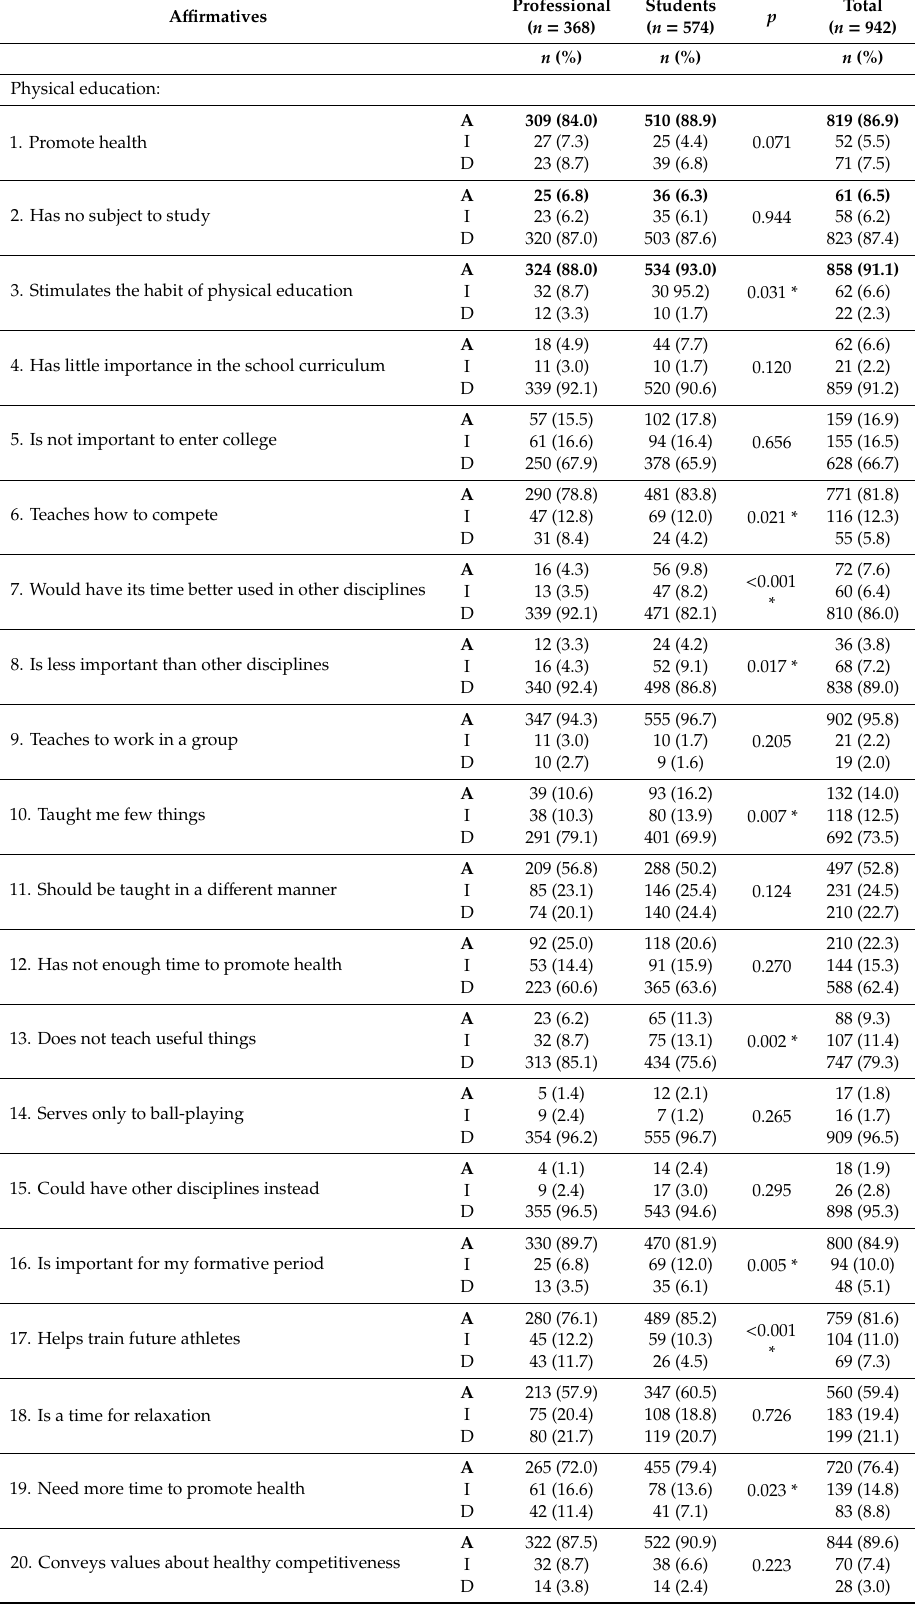
Table 2. Questionnaire on the role of school physical education